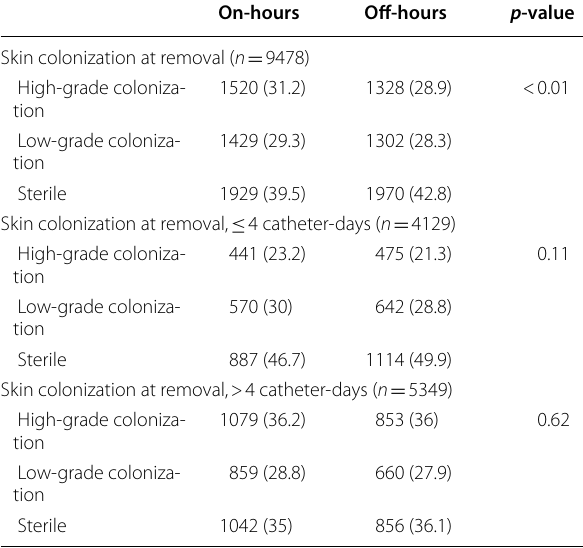
Table 3 Skin colonization at catheter